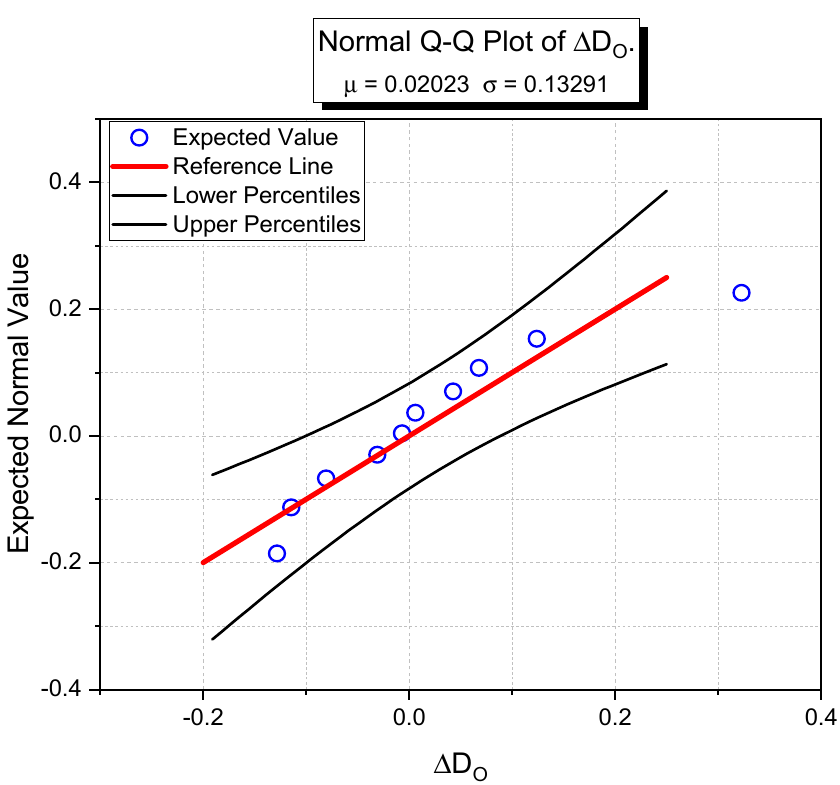
Figure 11. Q-Q plot of calculated oxygen diffusion coefficient error.